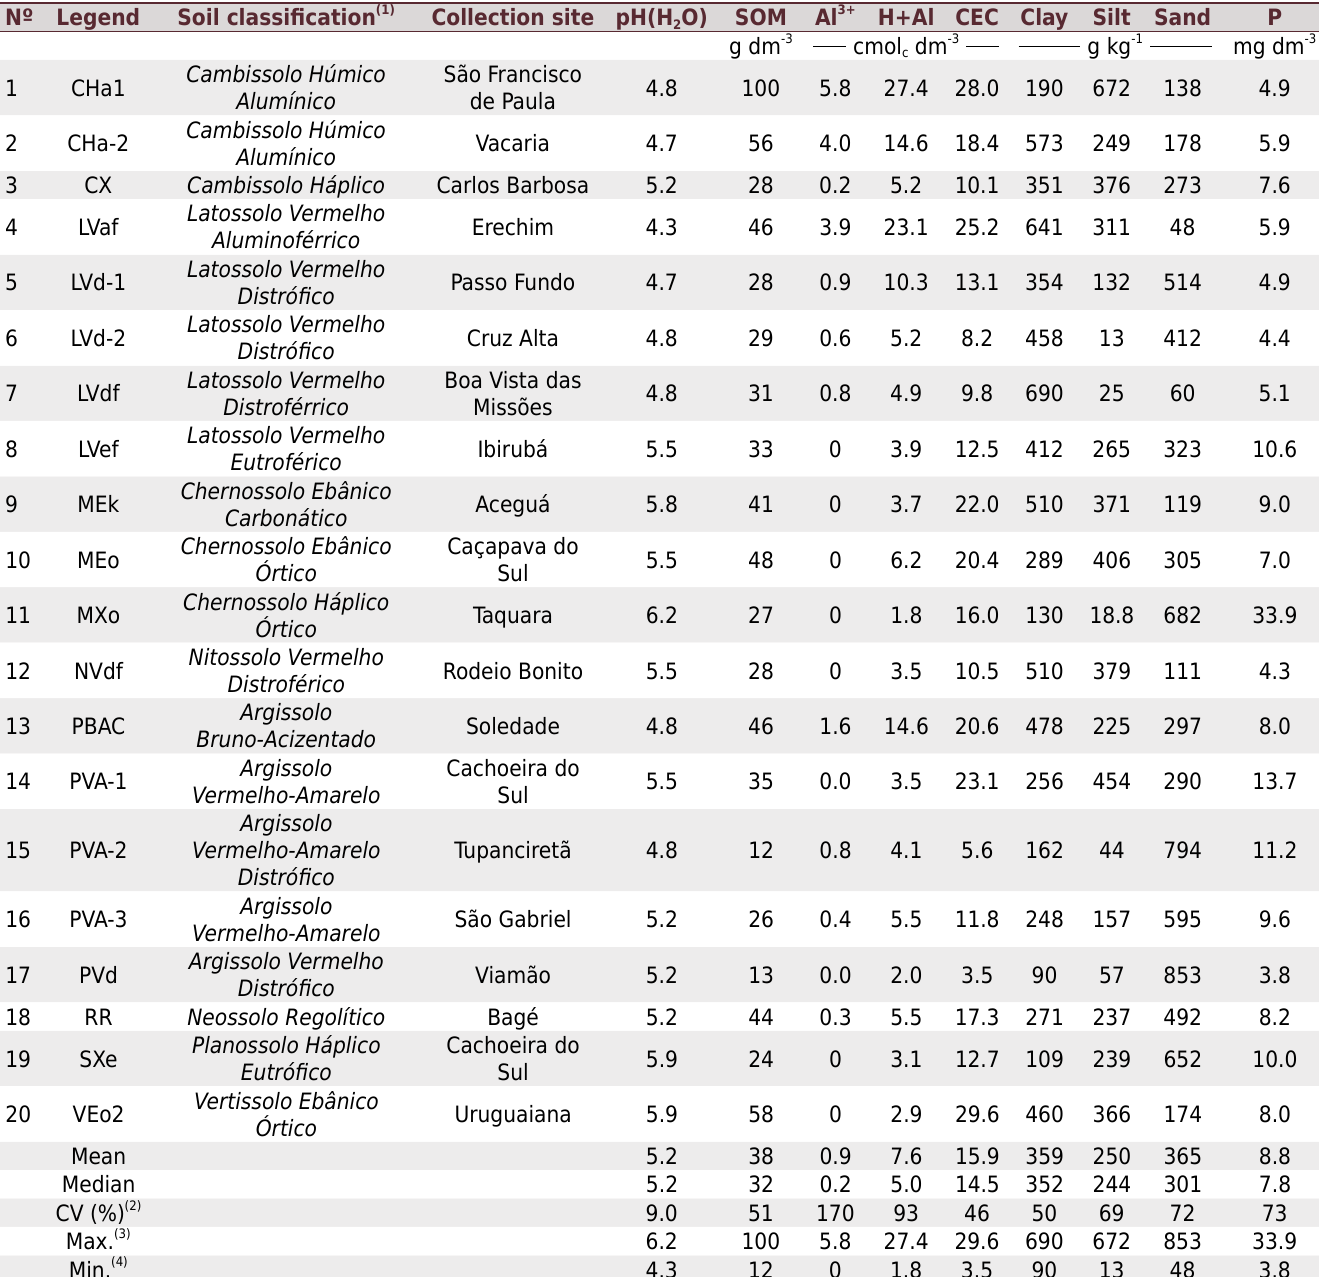
Table 1. Physical and chemical characterization of the 0.00-0.20 m layer of the